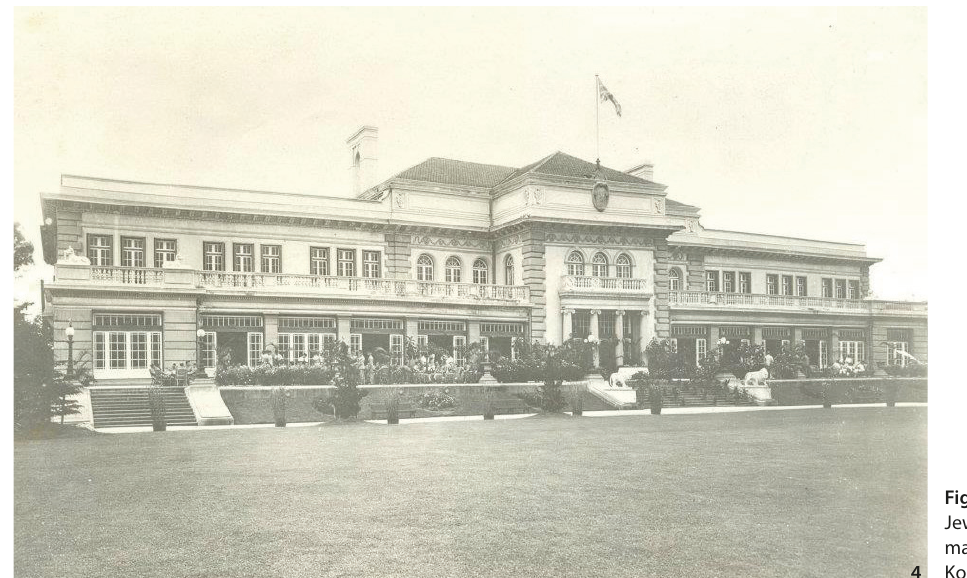
Figure 4 View of the Shanghai Jewish Club and Mr. Kadoorie’s mansion (Source: The Hong Kong Heritage Project,